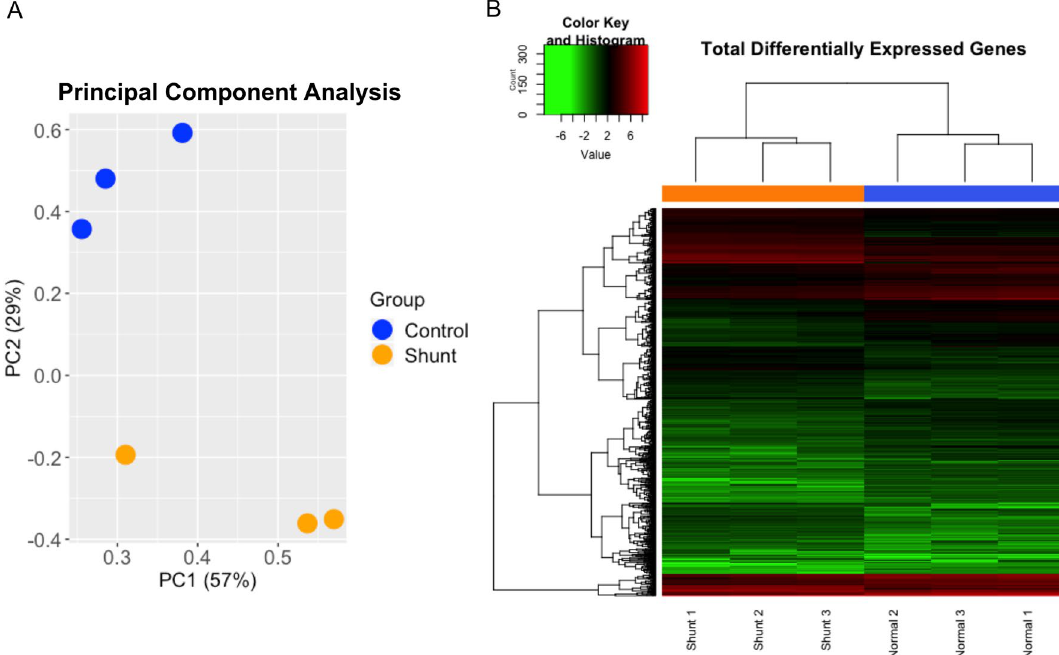
Figure 1. Transcriptional profiling of cultured lymphatic endothelial cells (LECs) isolated from control and shunt lambs. ( A ) Principal component (PC) analysis and ( B ) heat map of RNA-sequencing data demonstrate clustering of differentially expressed genes (DEGs) by model, N = 3 control, 3